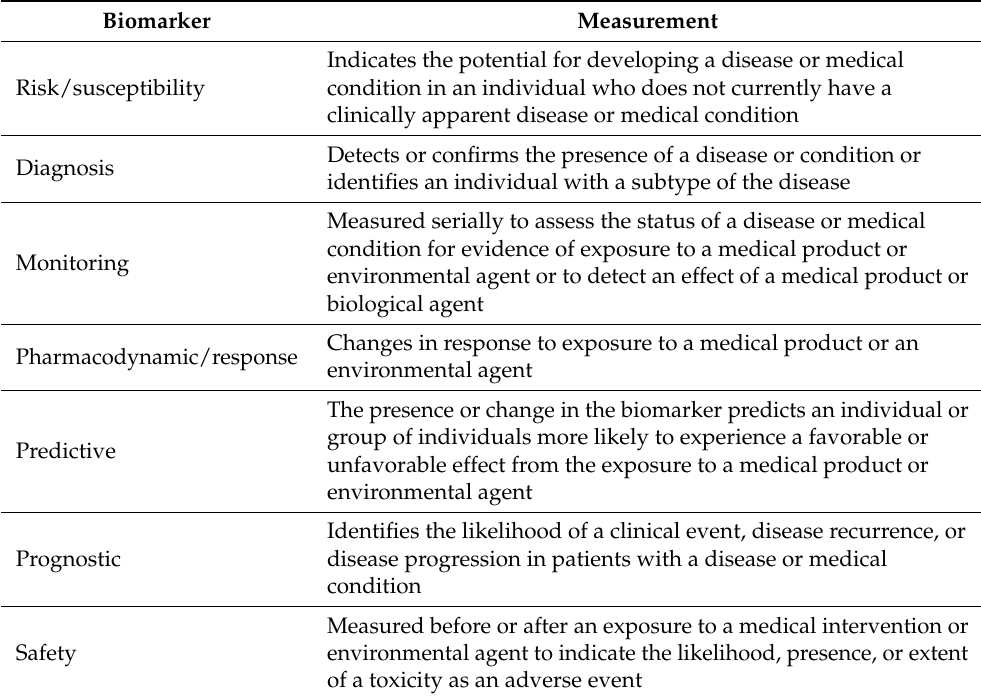
Table 1. FDA BEST classification of biomarkers use in drug development [5].